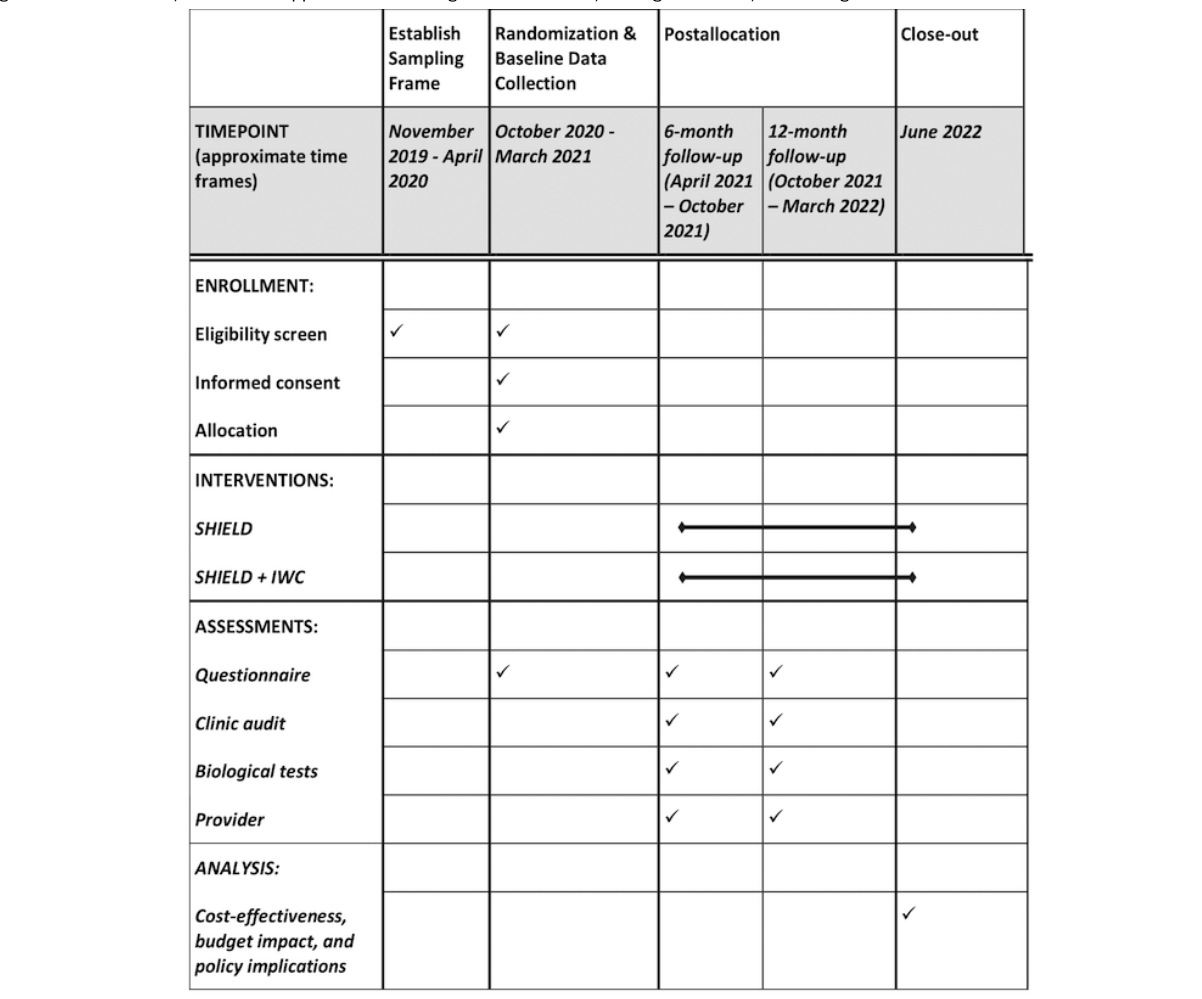
Figure 3. Standard Protocol Items: Recommendations for Interventional Trials (SPIRIT) flow diagram of the cluster-randomized controlled trial. IWC: integrated wellness care; SHIELD: Support for HIV Integrated Education, Linkages to Care, and